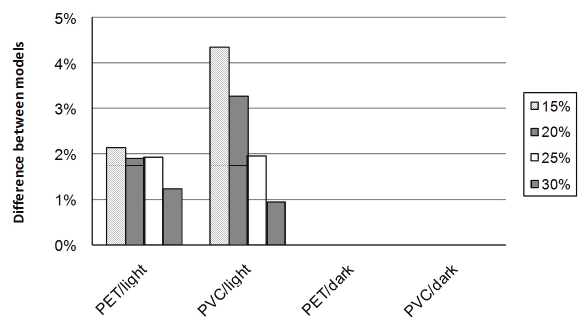
, for several safe